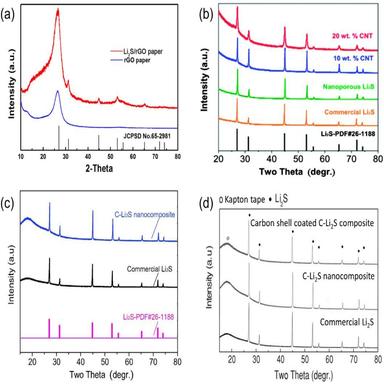
The XRD patterns of four representative Li2S-C composites. (a) Li2S/rGO paper ; (b) Li2S-MWCNTs ; (c) Li2S@C ; (d) Li2S@HC . Reproduced from Refs. with permission from the American Chemical Society, Royal Society of Chemistry, and Wiley.